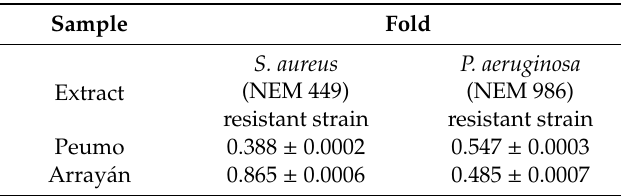
Data represent the average of four repetitions with corresponding standard errors of the mean. The data were analyzed with analysis of variance (ANOVA) ( p < 0.05) and the statistical significances within one bacterial strain were denoted by di ff erent letters ( a,b,c ). * Resistant to gentamicin, clindamycin, erythromycin, chloramphenicol, vancomycin, ciprofloxacin, methicillin, penicillin G, cefotaxime, and tetracycline. ** Resistant to gentamycin,